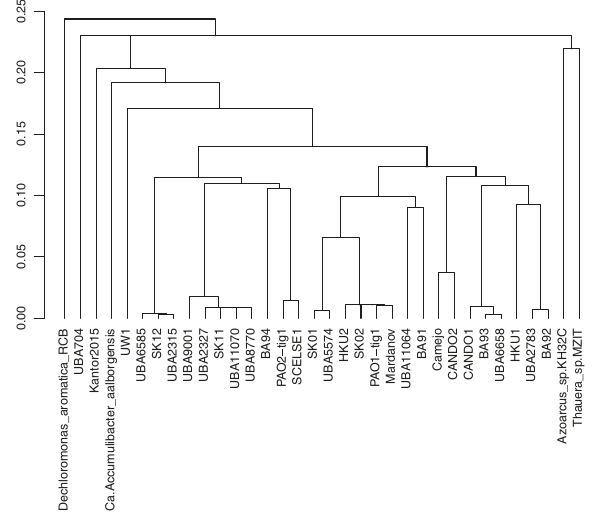
Fig. 3 Dendrogram generated from MASH distances between draft genomes of Candidatus Accumulibacter, including two genomes recovered in the present study. Genomes from genera Thaurea , Azozarcus and Dechloromonas were used as an outgroup. Note the structure of the tree recapitulates previously de fi ned clade associations ( Clade IIF : BA94, SK11, SK12; Clade IIC : BA91, SK-02, SK01; Clade I : BA92 and BA93. With UW1 being a singleton for Clade IIA ). See Supplementary Material for GenBank assembly accession identi fi ers corresponding to node